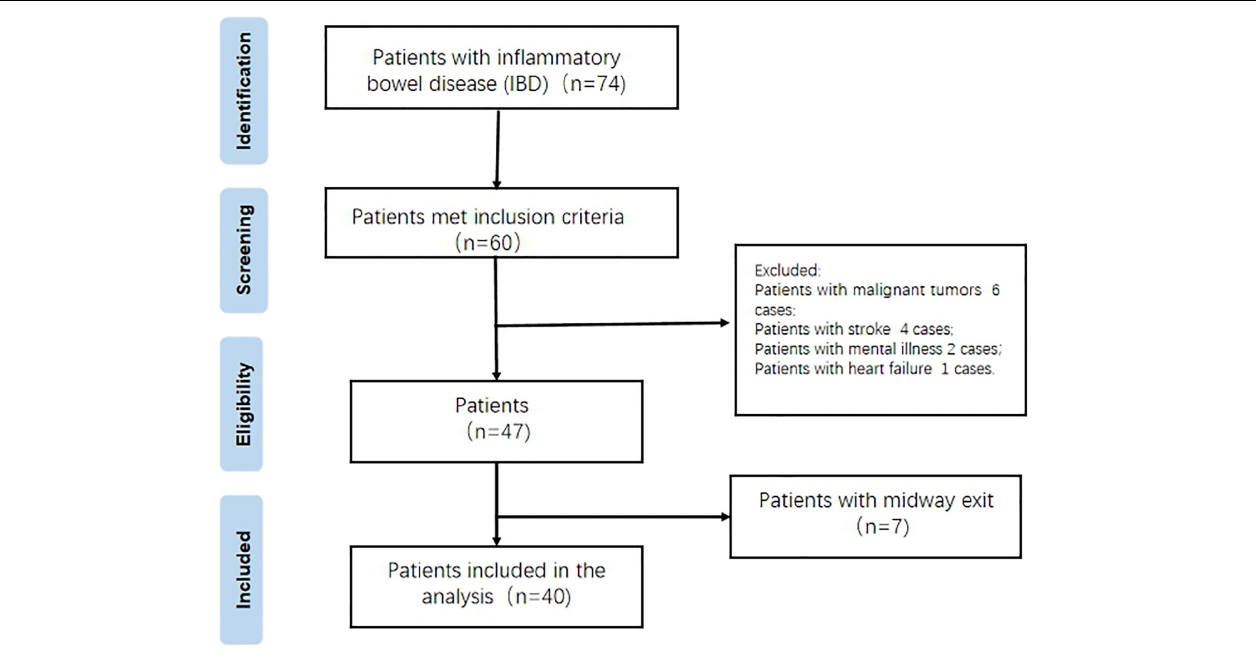
FIGURE 1 | The flow